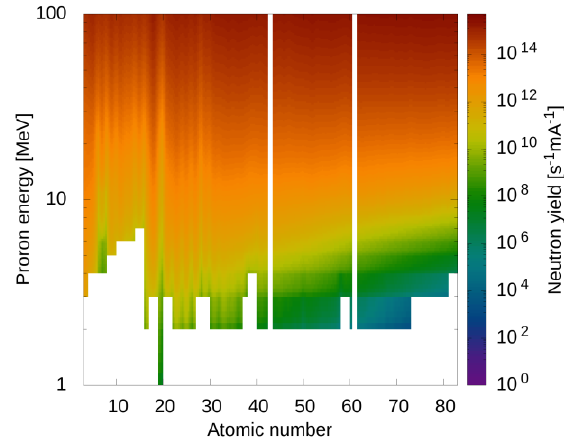
Figure 3: Proton induced neutron yield for various target materials determined from the cross sections calculated with the TALYS nuclear code [13] and the stopping powers calculated with the SRIM 2013 toolkit [14].